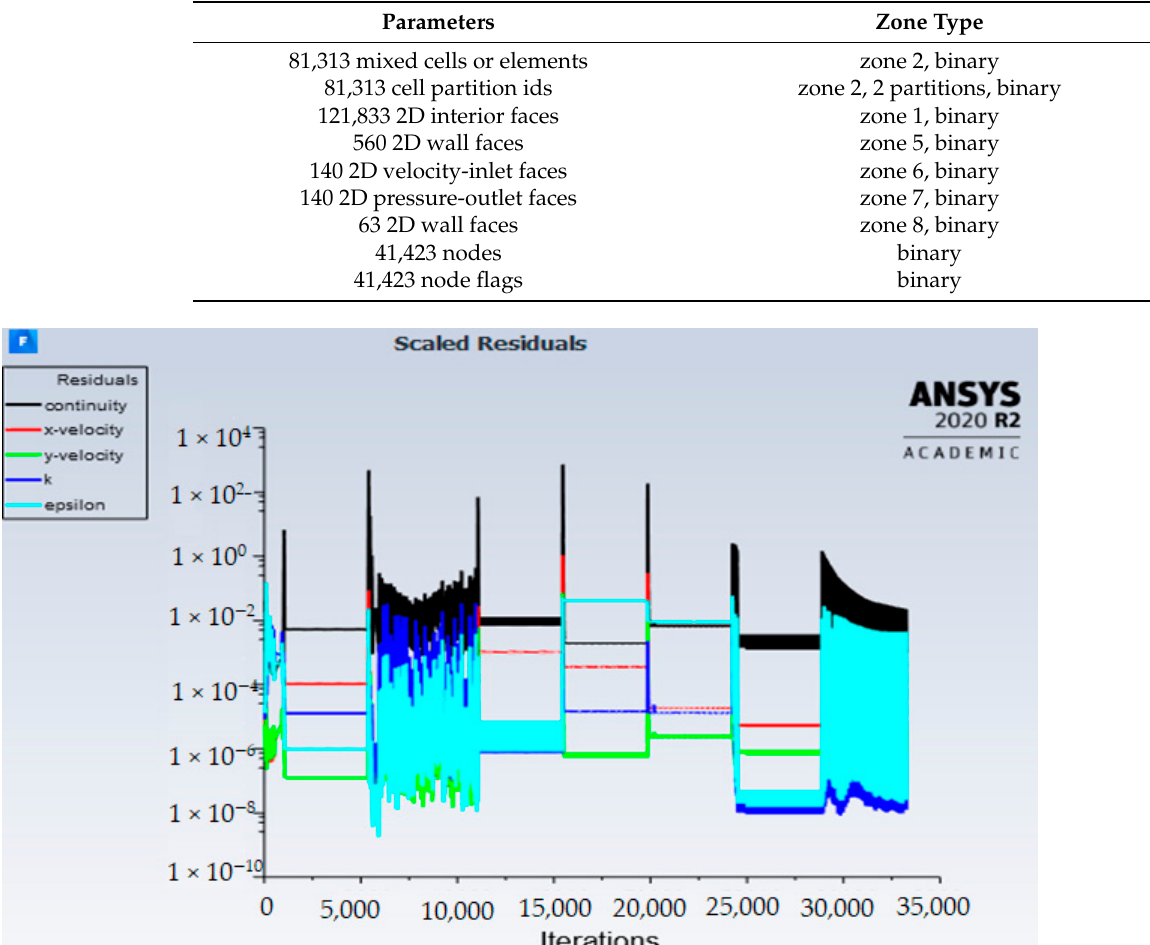
Table 3. Mesh statistics for the CFD model.